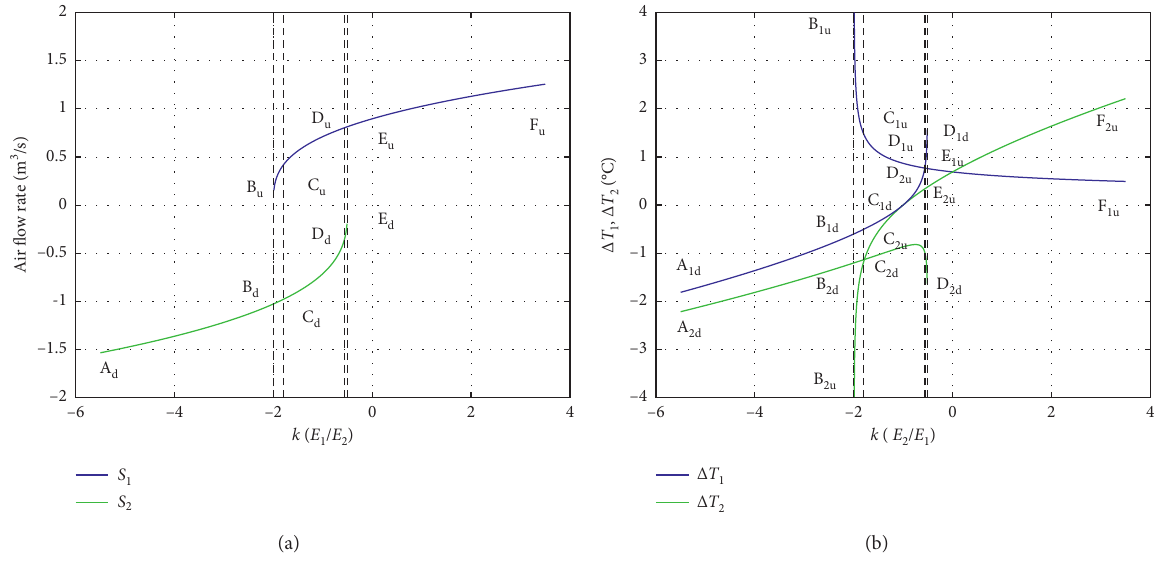
Figure 3: Bifurcation diagram. (a) Air flow rate. (b) Temperature. In the symbols, X subscript #(1, 2) indicates the zone number, and ∗ ( d,u ) refer to downward and upward flows,